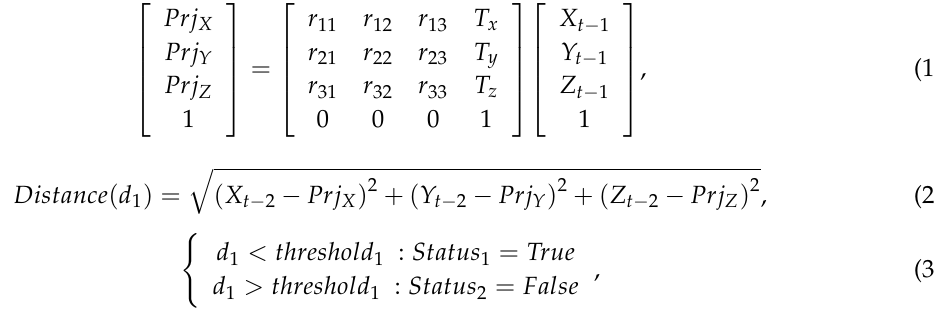
Figure 5. Corresponding point verification concept diagram.